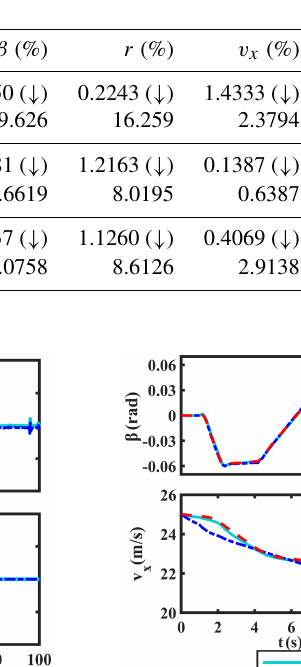
Table 2. The MAPE of UKF on β , r , v x , and a y .